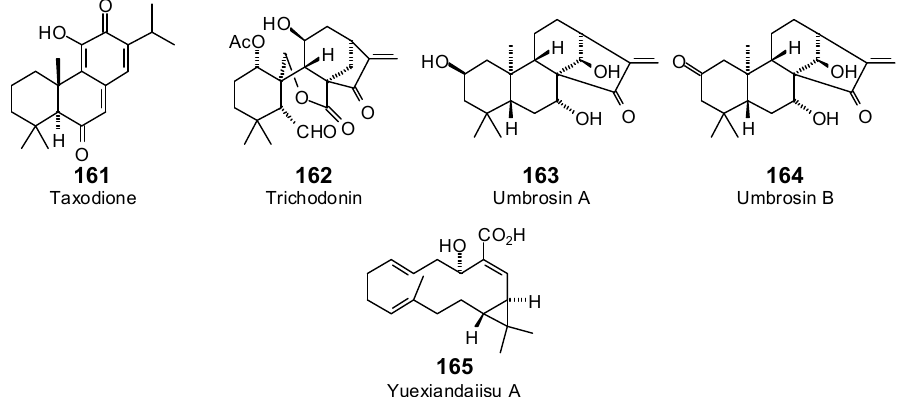
Figure 7. Diterpenoids examined in this work.